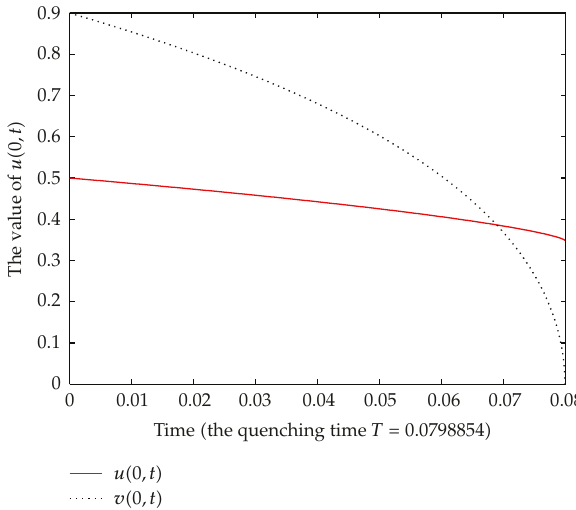
Figure 6: Evolution at the point x 0 (cid:3) 0 of the solution (cid:5) p 1 (cid:3) 0 . 6 , q 1 (cid:3) 0 . 5 , p 2 (cid:3) 2 , q 2 (cid:3) 1 (cid:6) .